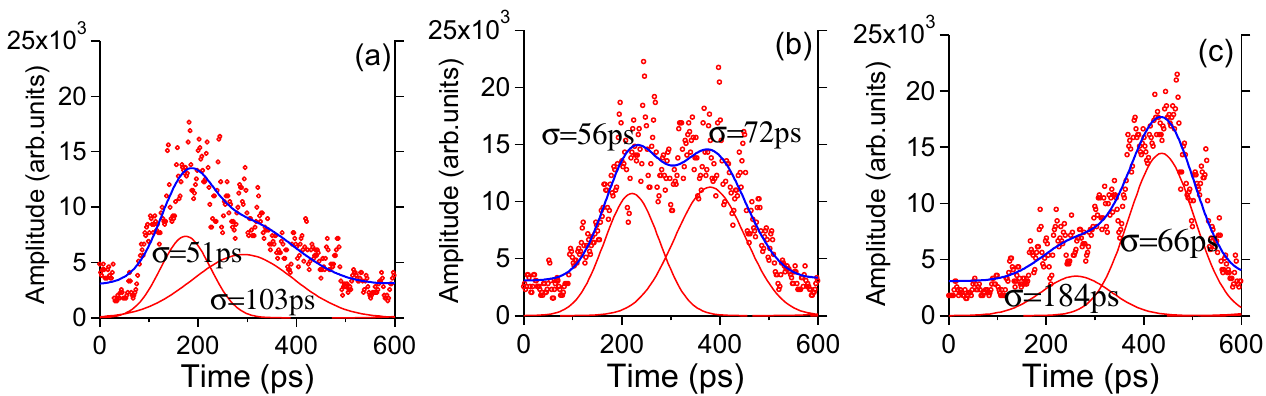
FIG. 17. (Color) Bunch profile in the tail (a), in the middle (b), and in the head (c) of the bunch train in case of a fractional filling of (cid:1) 315 mA , 2.0 96%, 3HC detuned of (cid:7) 64 kHz ; I beam